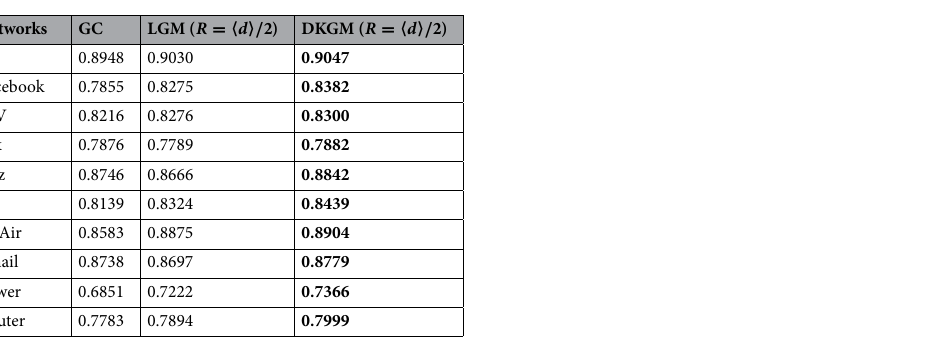
Table 8. The accuracies of GC, LGM ( R = � d � / 2 ) and DKGM ( R = � d � / 2 ) for β = β c . The best algorithm for each network is emphasized by bold.